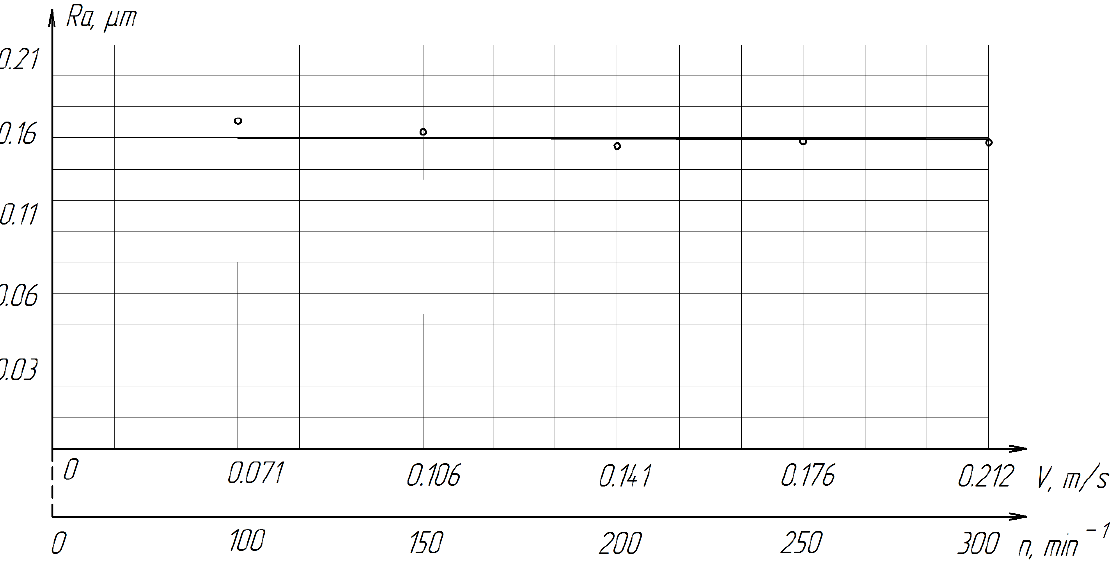
Figure 15. The effect of the cutting speed on the roughness of the treated surface of ZrO 2 ceramics.